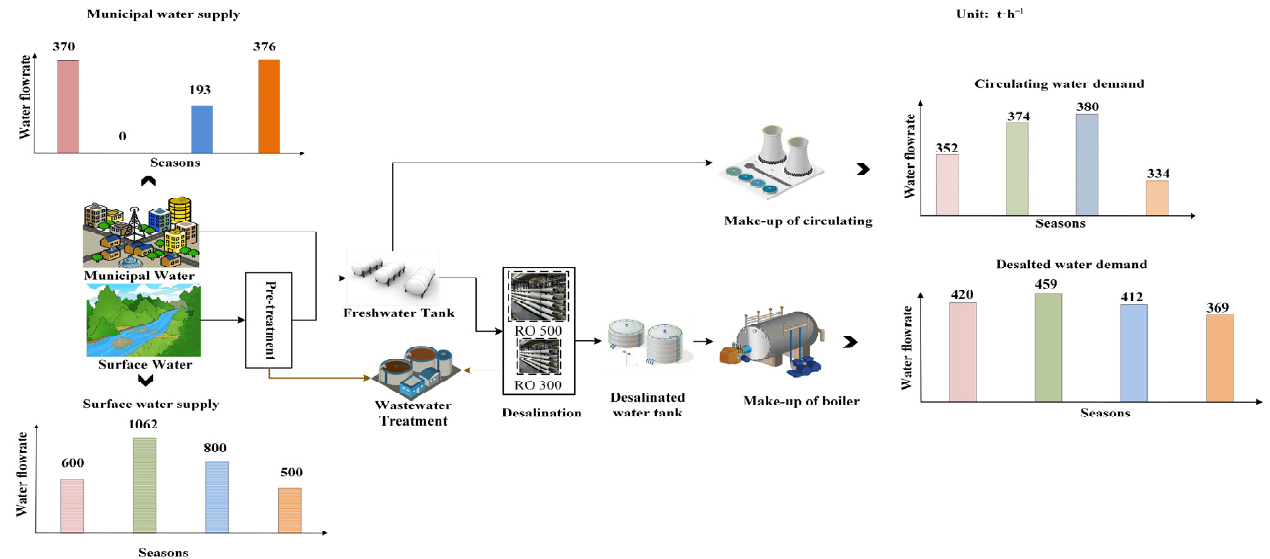
Figure 6. Optimal water supply network (Scenario 3).